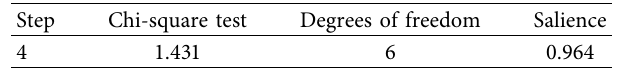
Table 20: Hosmer–Lemeshow tests.